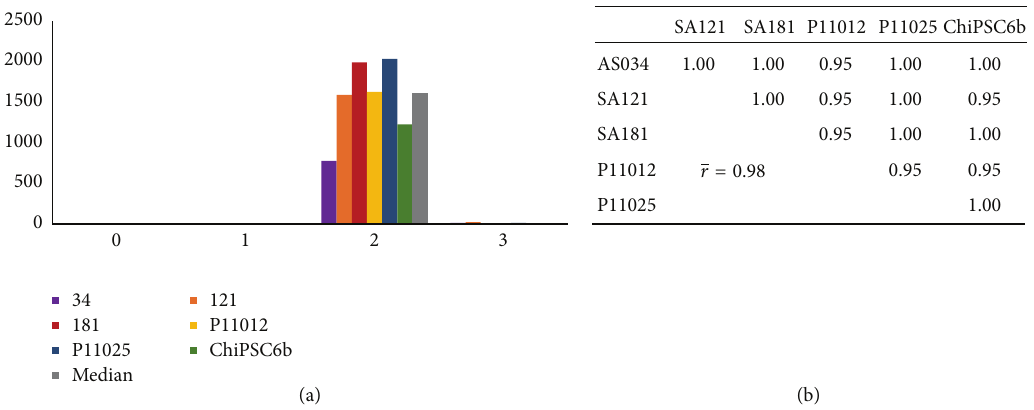
Figure 4: (a) Bar graph showing the RNA expression levels of the primitive streak marker 𝑇 . The 𝑥 -axis indicates the day of differentiation and the 𝑦 -axis indicates RQ, where the calibrator’s RQ = 1. All six cell lines express the 𝑇 gene essentially only at day 2; therefore, the correlation between cell lines for the interval of day 0 to day 3 is very strong as indicated in